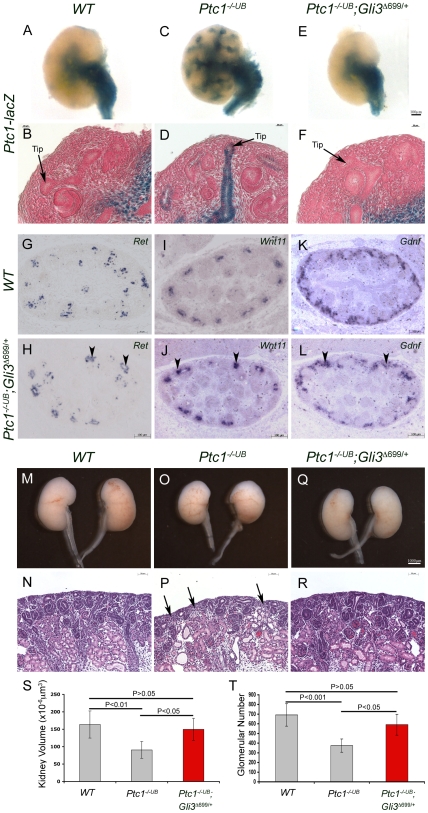
GLI3 repressor is required for ureteric tip cell-specific gene expression and function.(A–F) Normal of HH signaling activity is restored in Ptc1−/−UB;Gli3Δ699/+ kidneys at E13.5. In contrast to Ptc1−/−UB kidneys, Ptc1-lacZ expression is absent from the cortical collecting ducts and ureteric bud tips in Ptc1−/−UB;Gli3Δ699/+ kidneys. (G–L) Expression of Ret, Wnt11 and Gdnf was restored in Ptc1−/−UB;Gli3Δ699/+ kidneys at E13.5. Analysis of Ptc1−/−UB;Gli3Δ699/+ kidneys at E18.5 revealed a restoration in kidney size (M,O,Q) and density of the nephrogenic zone (N,P,R). Kidney volume (S) and glomerular number (T) is rescued in Ptc1−/−UB;Gli3Δ699/+ kidneys to comparable levels to WT littermates.